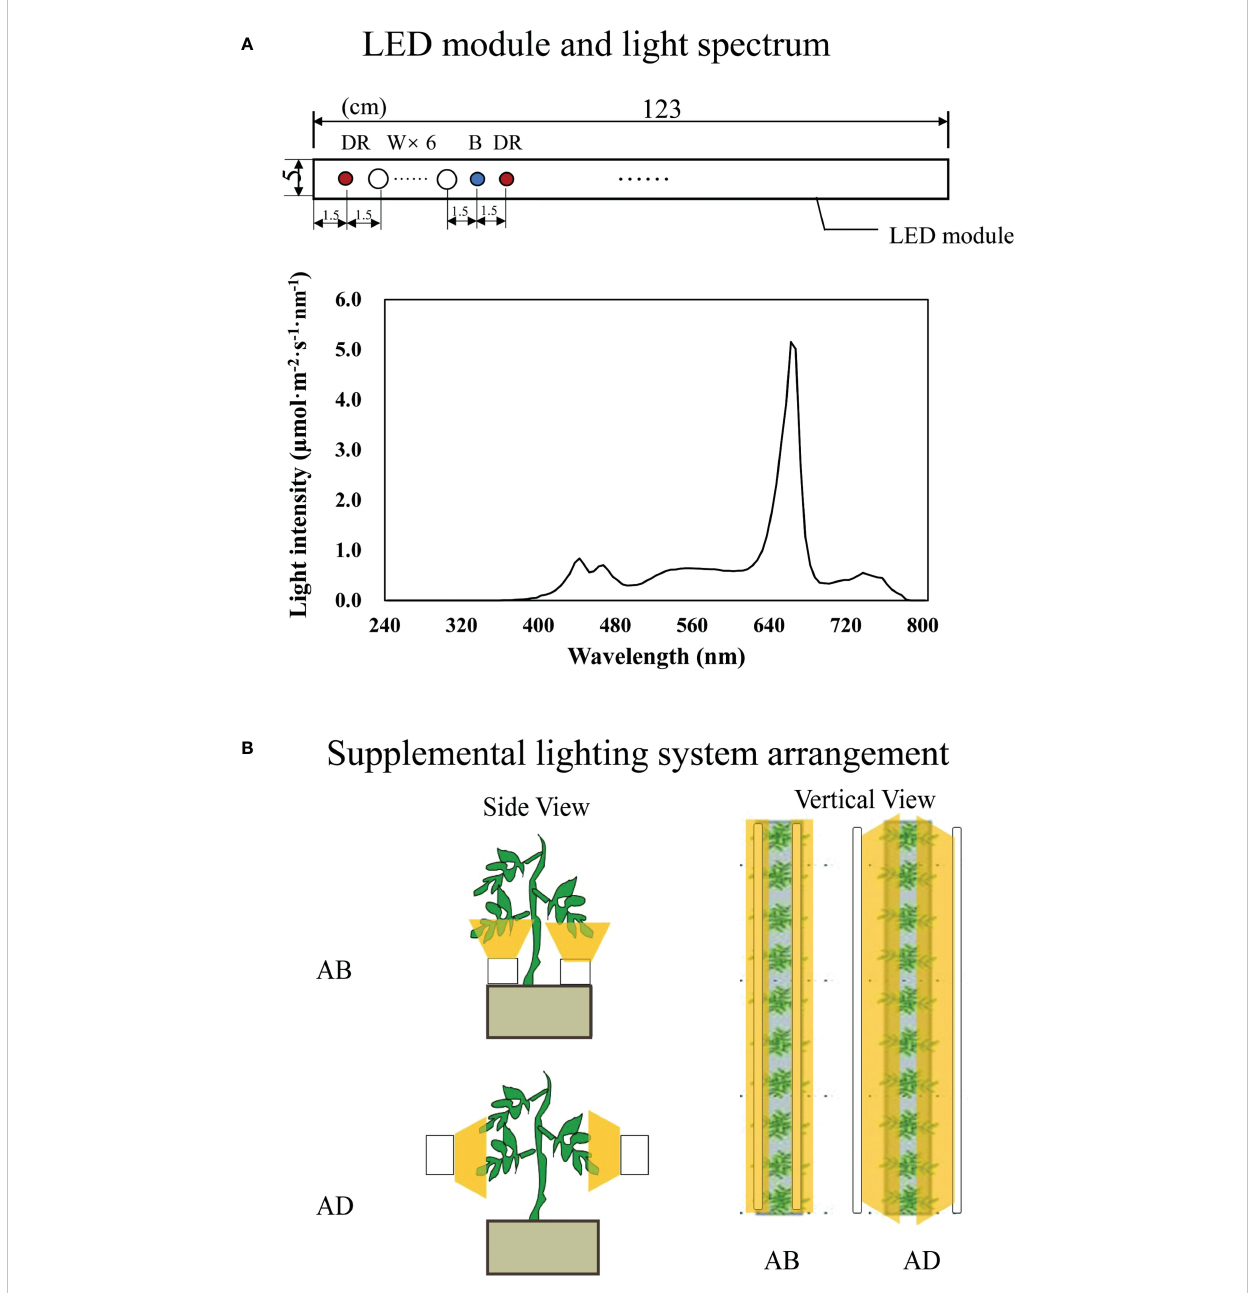
FIGURE 1 Schematic diagram of LED module characters (A) and the supplemental lighting arrangement (B) . Abaxial leafy supplemental lighting (AB) and the adaxial leafy supplemental lighting (AD) was applied to plants from the 14 th day after transplanting. The supplemental lighting is powered by deep red, white and blue (DR/W/B) LEDs. Each LED module is at a size of 123×5cm and contains 9 groups of color chips (diameter of 7 mm with axis arrangement) at 1DR+6W+1B+1DR (A) . LEDs were provided 10 cm from the abaxial or adaxial epidermis of leaves (B) , with a PPFD of 200 m mol·m − 2 ·s − 1